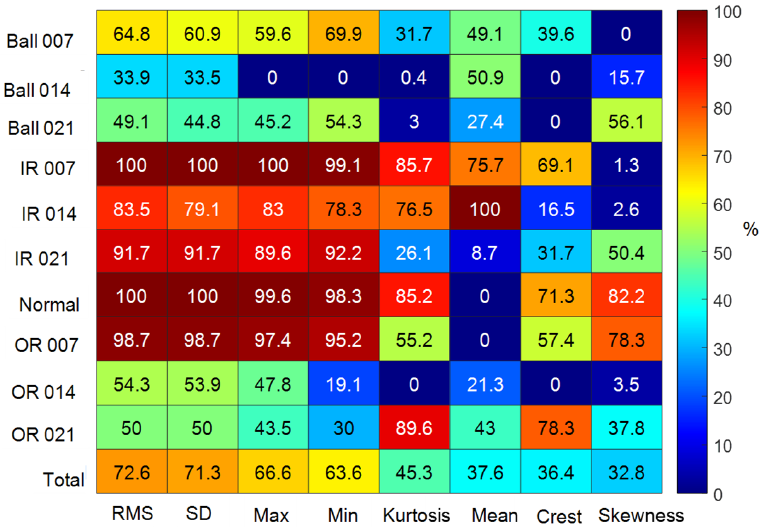
Figure 13. Results of predicting motor bearing failure with only one